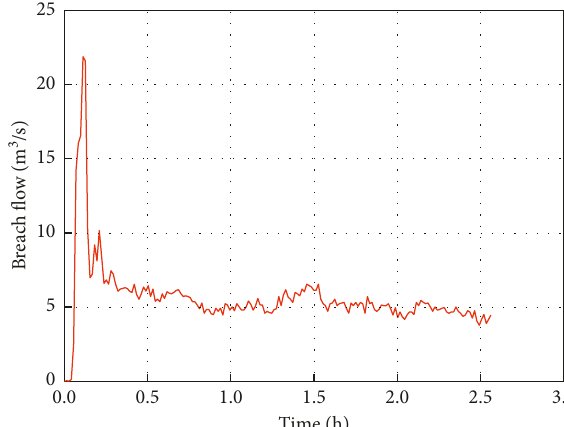
Figure 5: The breach flow